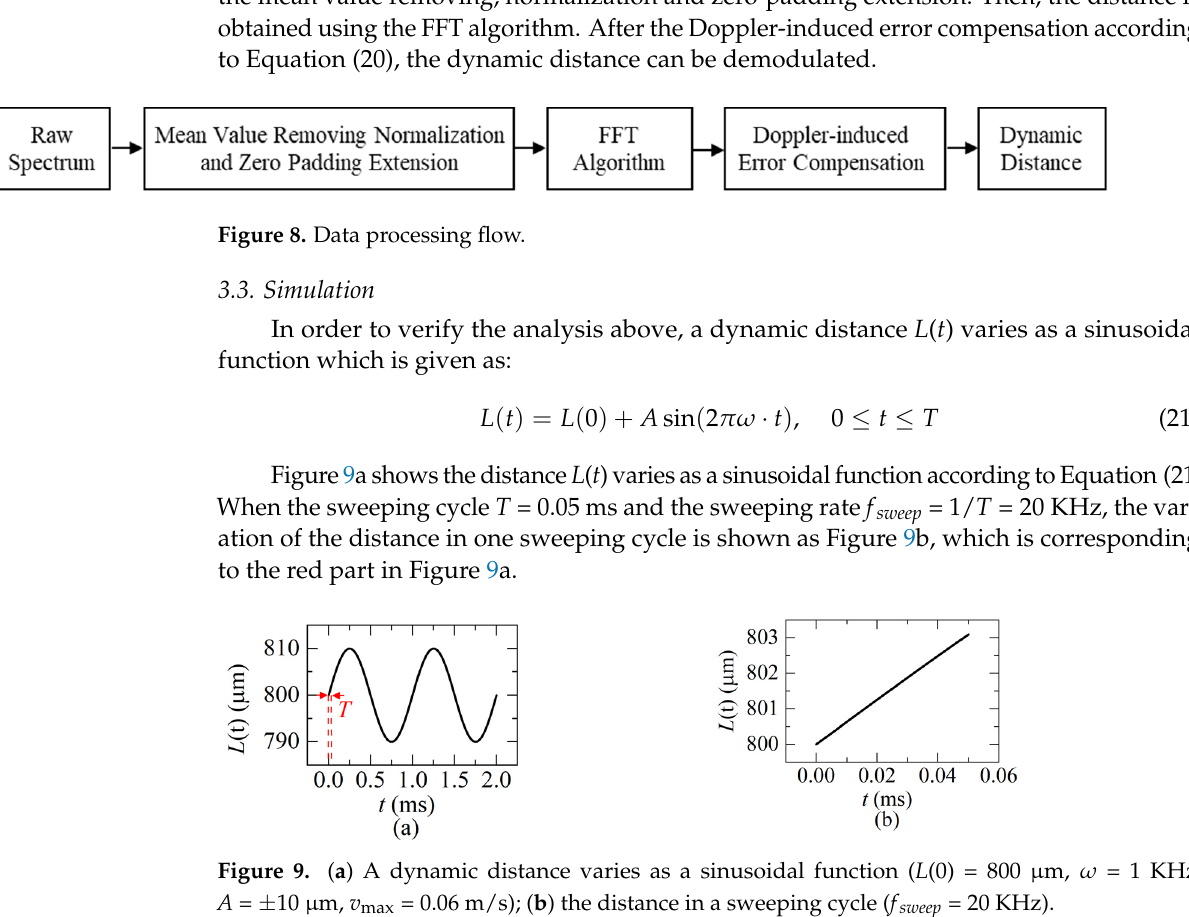
Figure 9. ( a ) A dynamic distance varies as a sinusoidal function ( L (0) = 800 μ m, ω = 1 KHz, A = ±10 μ m, v max = 0.06 m/s); ( b ) the distance in a sweeping cycle ( f sweep = 20 KHz).